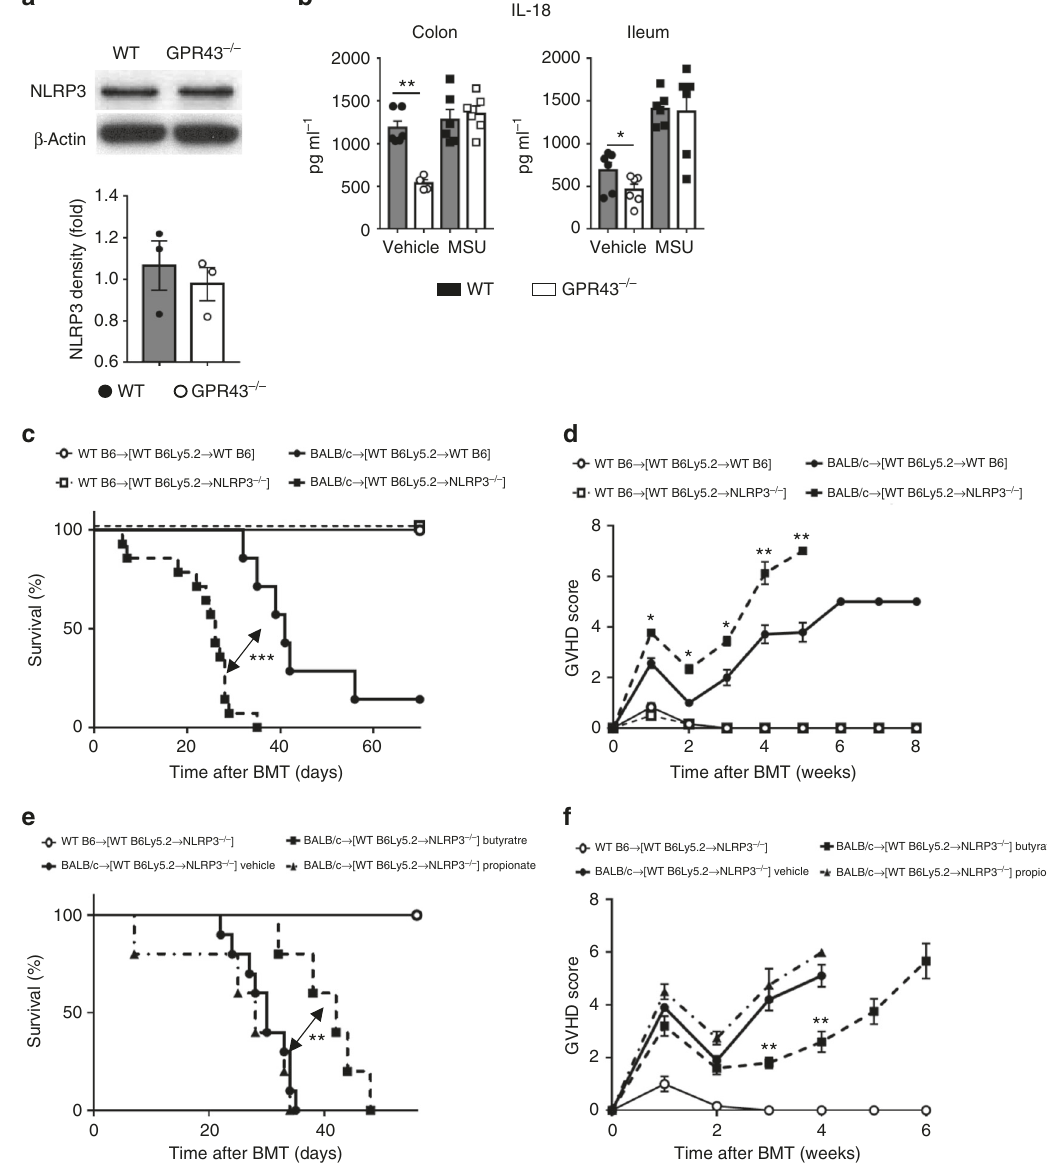
Fig. 6 NLRP3 de fi ciency in non-hematopoietic cells exacerbates GVHD and is not rescued by propionate. B6 WT and Gpr43 − / − mice received BMT from either syngeneic B6 or allogeneic BALB/c donors. a Representative immunoblots and densitometric analysis of NLRP3 normalized to the presence of β - actin in IECs (CD326 + ) from allogeneic recipients 14 days after BMT ( n = 3 each, two-tailed Mann – Whitney U test). b IL-18 production by colon and